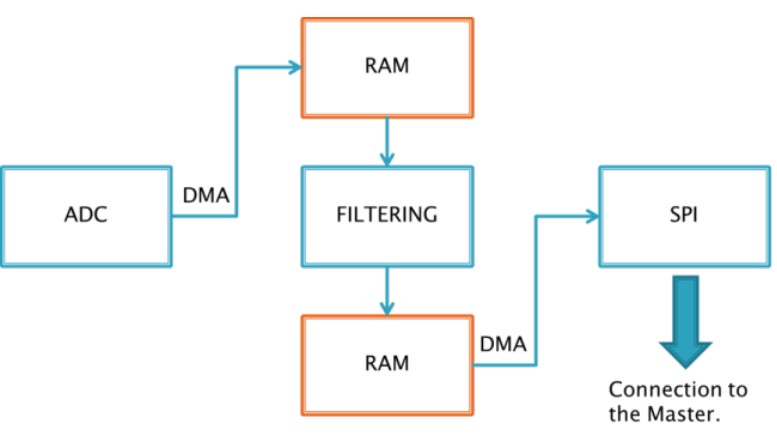
Figure 4. Overview of sub-module